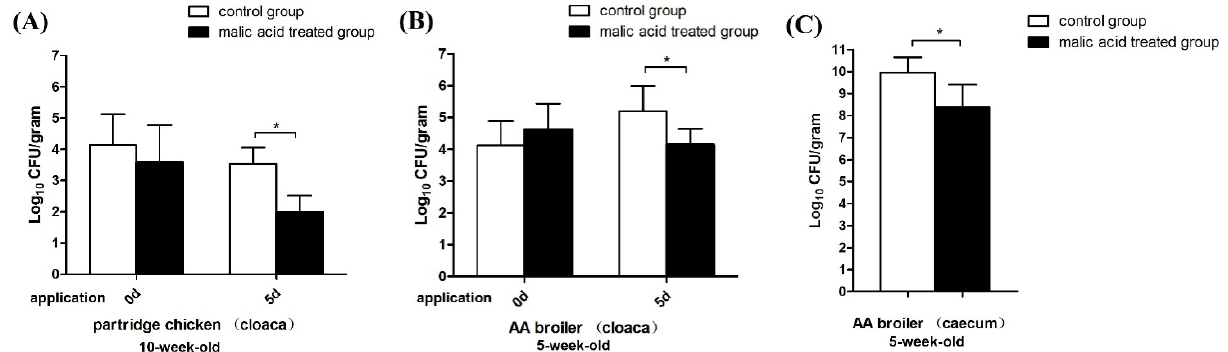
Figure 2. Campylobacter carriage in the chicken cloaca and caecum after the use of malic acid for five days. The partridge chickens ( A ) and AA broilers ( B ) at slaughter age were provided with malic acid-supplemented drinking water and the cloacal swab samples were collected before the experiment and 5 days after to determine the Campylobacter carriage. The caeca of the AA broilers were collected during slaughter to determine the load of colonized Campylobacter ( C ). Twenty chickens were assayed in each group, the data are presented as the mean ± SD, and asterisks indicate significant differences ( p < 0.05 *).